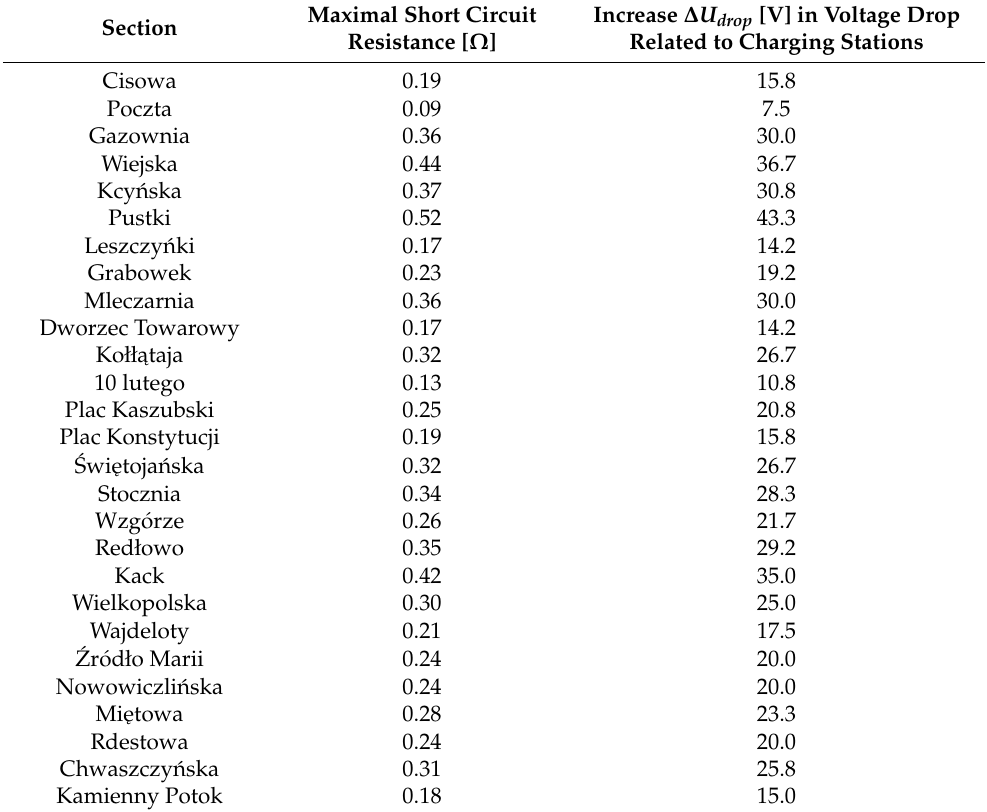
Table 3. Short circuit resistances and computed increase in voltage drops for particular power